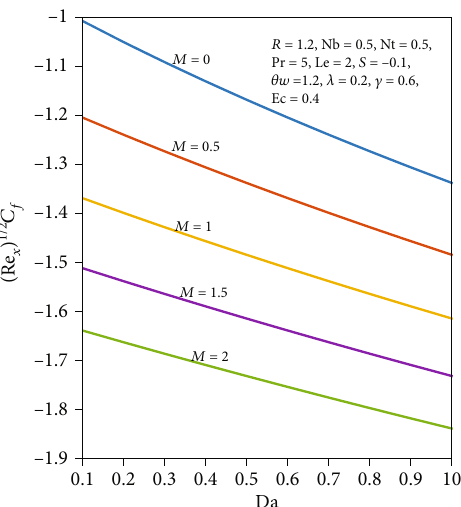
Figure 25: Local Nusselt number pro fi le for di ff erent values of S , R . Table 2: The numerical values of the skin friction coe ffi cient p ffiffiffiffiffiffiffi C Re x f and the local Nusselt number